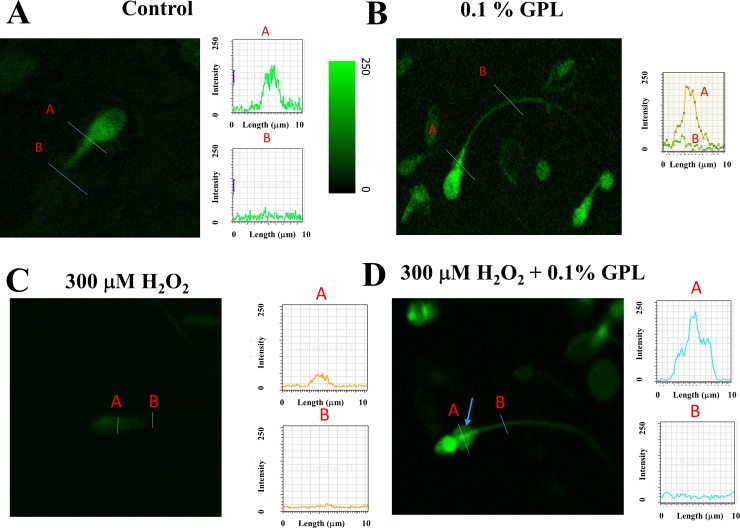
Confocal images of human sperm stained with Rhodamine 123 under different experimental conditions.Segment A has been inserted in a sperm sector enriched in mitochondria, whereas segment B has been placed in a sector devoid of mitochondria. Fluorescence intensity plots from segments A and B are shown to the right. (A) A typical spermatozoon stained with Rhodamine 123 under control conditions. (B) A sperm stained with Rhodamine 123 in medium containing 0.1% GPL. (C) A typical spermatozoon stained with Rhodamine 123 in medium containing 300 μM H2O2. (D) A sperm stained with Rhodamine 123 in 300 μM H2O2 with 0.1% GPL.